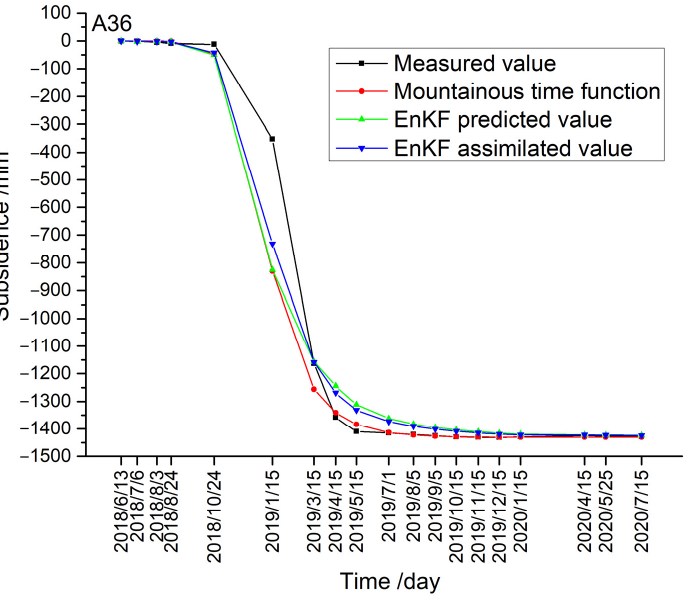
Figure 9. Subsidence curves of A36 using different methods.